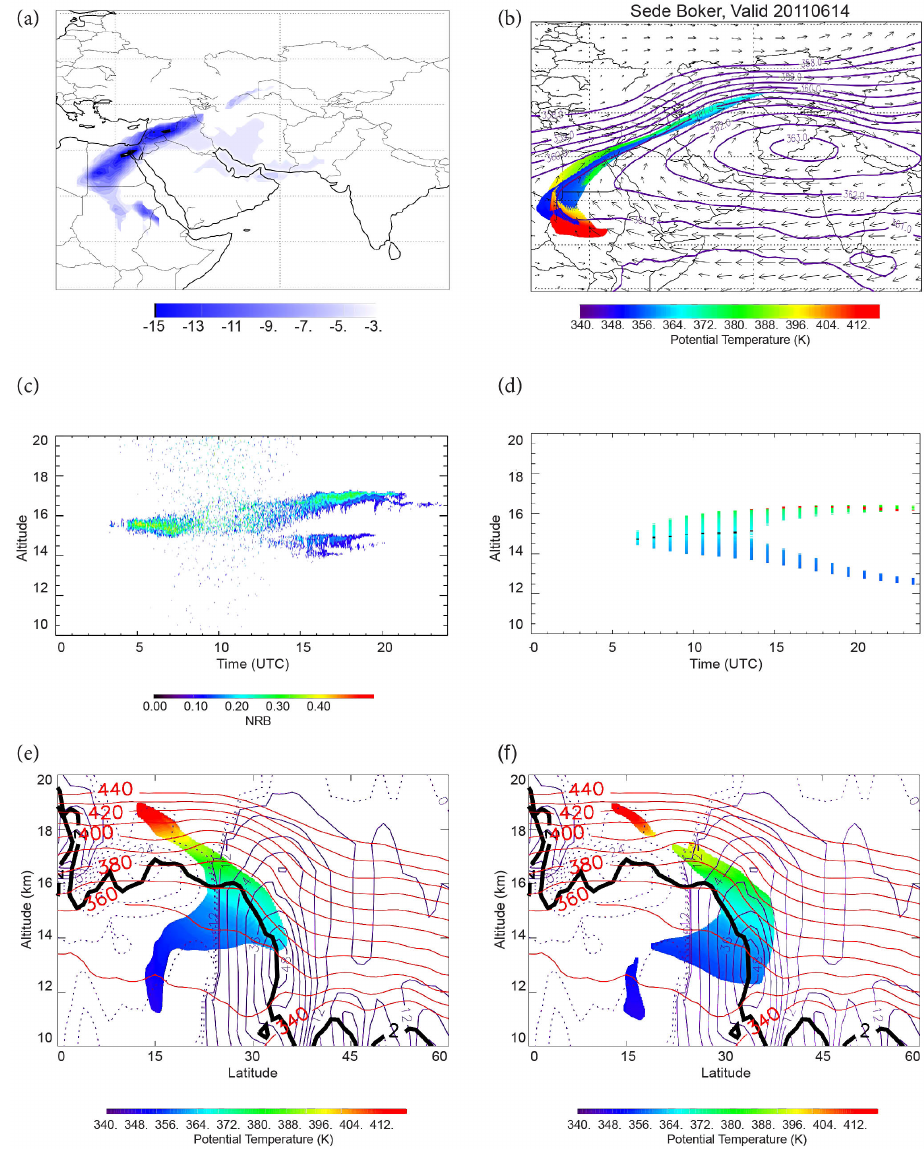
Figure 2. Maps of (a) SO 2 index, based on BT differences assembled from AIRS/Aqua, for 14 June 2011, and (b) simulated air parcel locations for the same day; (c) time–height curtain of normalized backscatter from the MPLNET site at Sede Boker, Israel, on 14 June, and (d) corresponding curtain of trajectory locations. MPLNET data provided courtesy of A. Karnieli, B. Gurion University, Israel, and E. J. Welton, NASA GSFC. The air parcel trajectories are colored by their initial θ values, except for those for which PV = 2.0PVU (red), or θ = 380K (black); (e) and (f) cross sections of AM (left) and PM (right) air parcel locations at 35 ◦ E on 14 June, colored by initial θ together with 12:00Z wind speed, θ , and PV = 2PVU